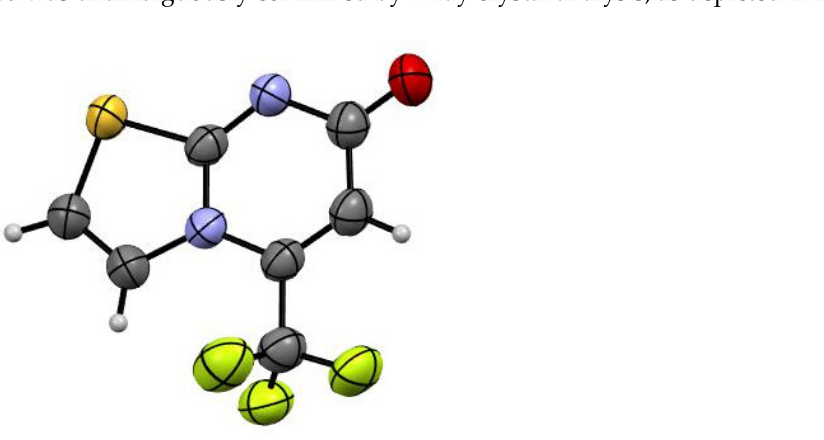
Figure 3. X-ray single-crystal structure of compound 3a .